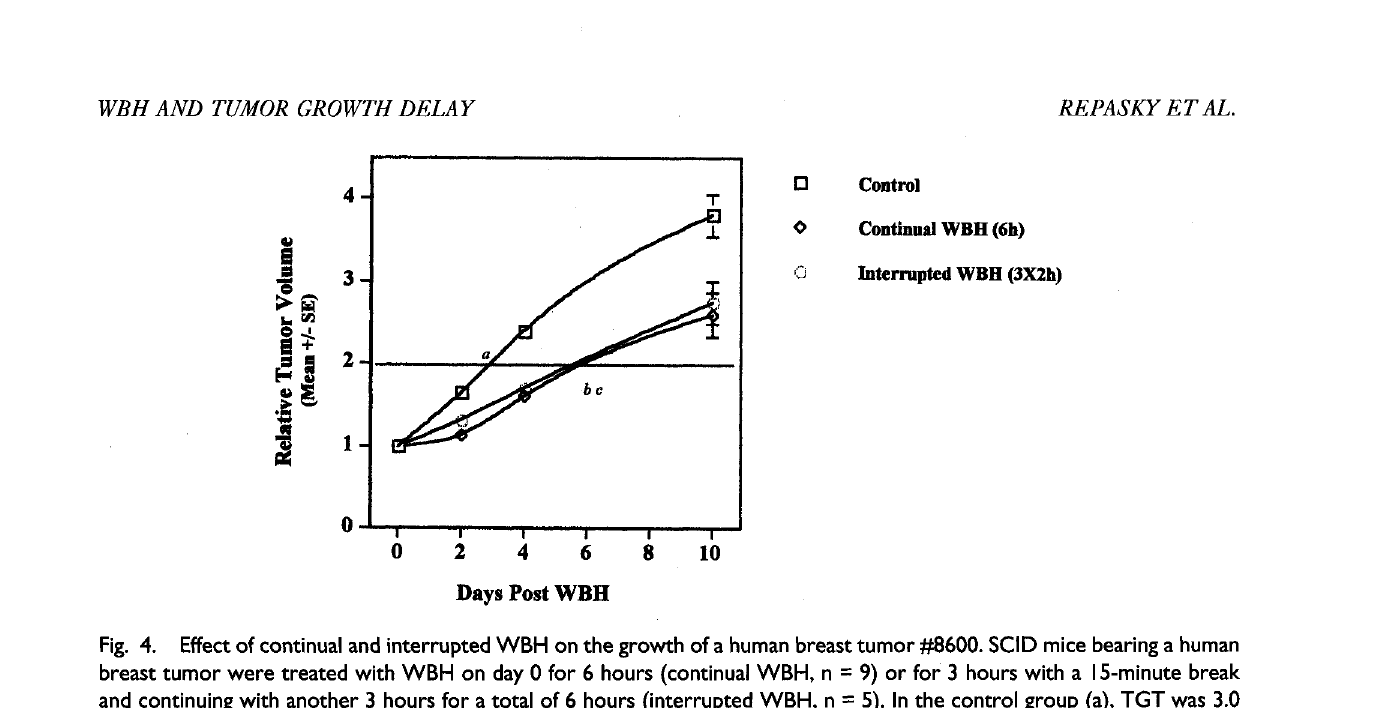
Fig. 4. Effect of continual and interrupted WBH on the growth of a human breast tumor #8600. SCID mice bearing a human breast tumor were treated with WBH on day 0 for 6 hours (continual WBH, n 9) or for 3 hours with a 15-minute break and continuing with another 3 hours for a total of 6 hours (interrupted WBH, n 5). In the control group (a), TGT was 3.0 + O.01d. In the continual WBH group (b), TGT was 7.3 + 0.8d (P < 0.01 when compared with the control). In the interrupted WBH group (c), TGT was 6.2 + 1.0d (P < 0.01 when compared with the